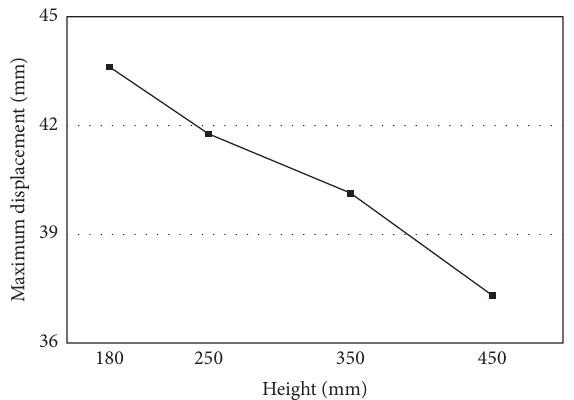
Figure 9: Effect of height of slabs on displacement.